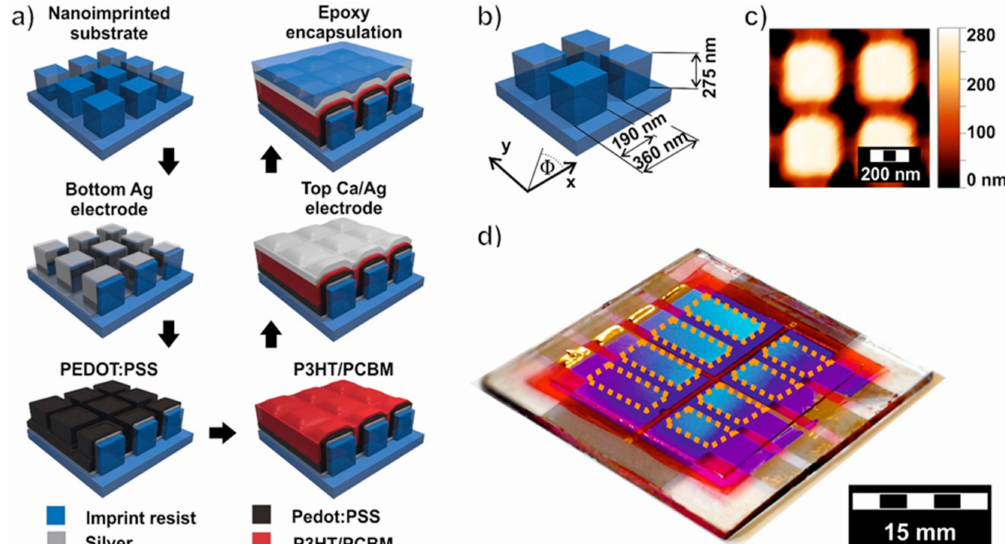
Figure 1. Manufacturing and detector details. ( a ) Fabrication of nanostructures on a glass substrate by nanoimprint lithography, followed by Ag deposition of the bottom electrode. Spin coating of PEDOT:PSS and P3HT / PCBM, metal deposition of the top electrode and encapsulation. ( b ) Schematic of a unit cell. ( c ) AFM topography image of the nanoimprinted substrate. ( d ) Photograph of the final device in true colors, comprising eight individual cells confined by the spatial overlap of the electrodes (indicated by dashed orange